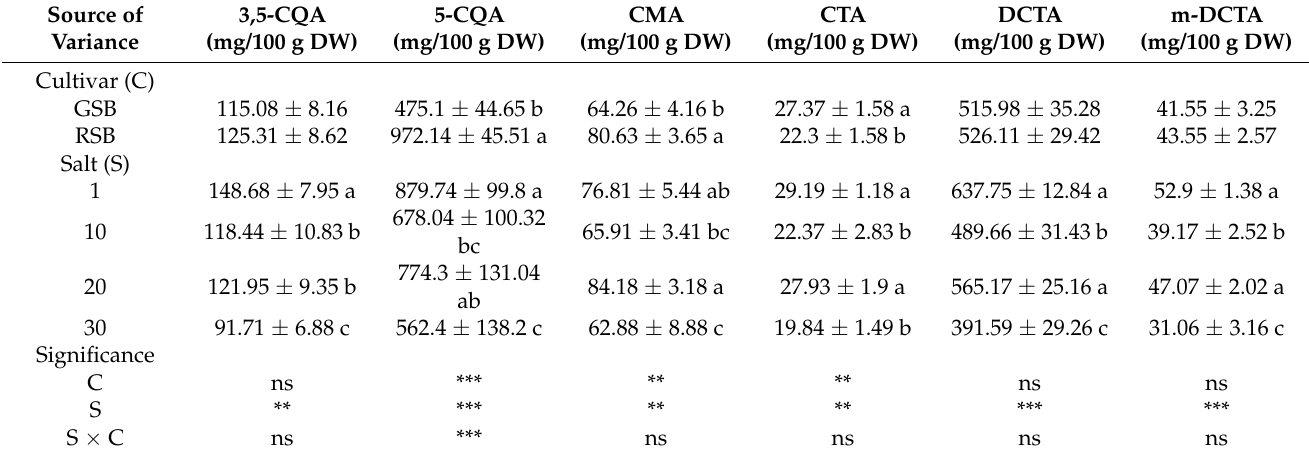
Table 4. Main effect of the cultivar (C), salt concentration (S; in mM NaCl), and their interaction on the leaf polyphenols. The significance of the factors and their interactions was evaluated with a two-way ANOVA (ns: not significant; **: p < 0.01; ***: p < 0.001), using Duncan’s multiple range test as post-hoc test for mean separation among conditions. In case of simple main effect of C or S, different letters indicate, for each variable, different homogenous groups according to Duncan’s test for S, or the Student’s t -test for C. GSB: ‘Green Salad Bowl’; RSB: ‘Red Salad Bowl’. Salt concentration is in mM NaCl. 3,5-CQA: isochlorogenic acid; 5-CQA: chlorogenic acid; CMA: caffeoylmalic acid; CTA: caffeoyltartaric acid; DCTA: cichoric acid;